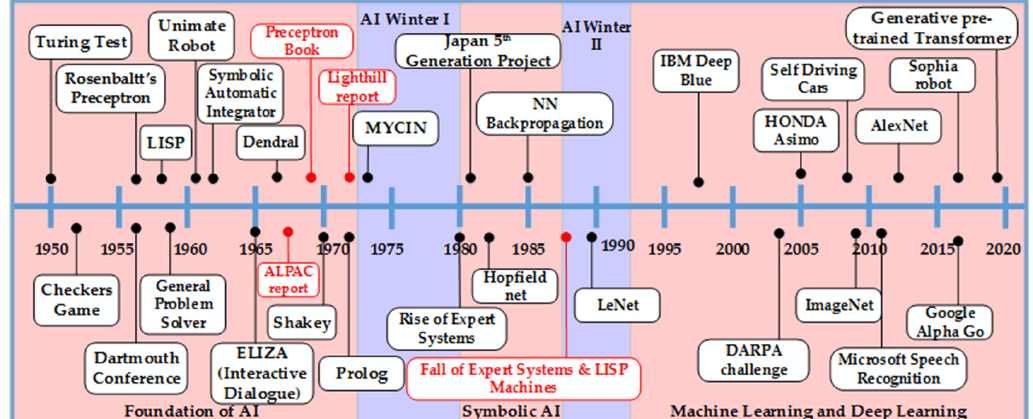
Figure 3. Artificial intelligence over the